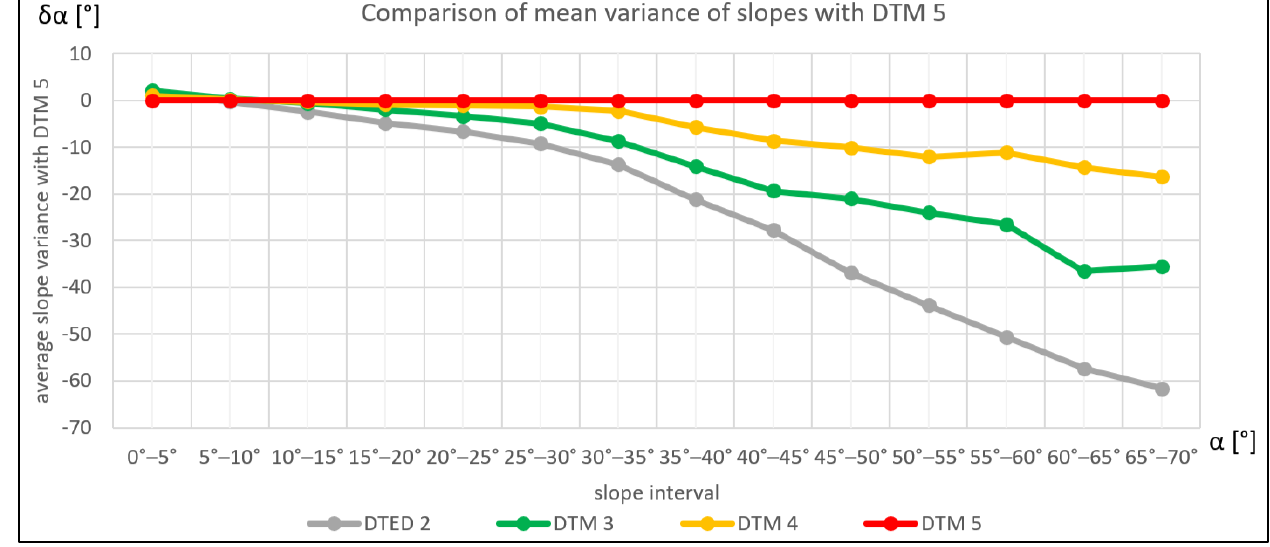
Figure 6. Graph comparing the mean variance of slopes of different terrain models (DTM 5, DTM 4,